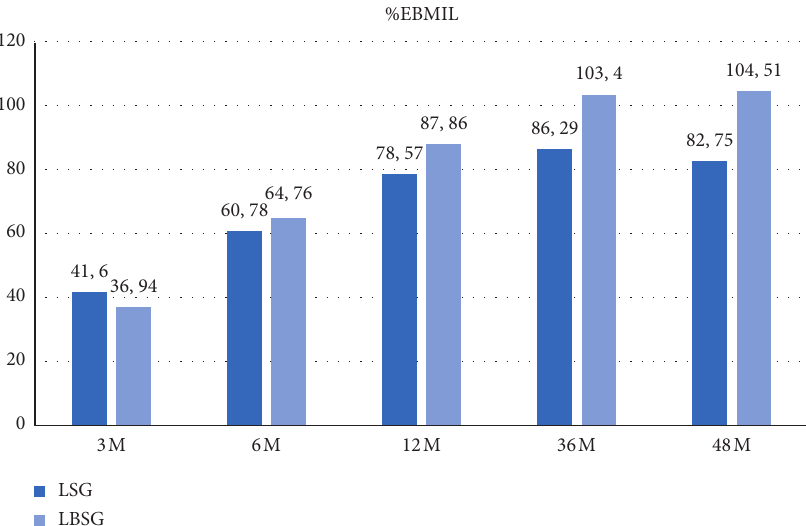
Figure 3: Variation of %EBMIL during the follow-up. LSG: laparoscopic sleeve gastrectomy; LBSG: laparoscopic banded sleeve gas- trectomy; %EBMIL: % excess body mass index